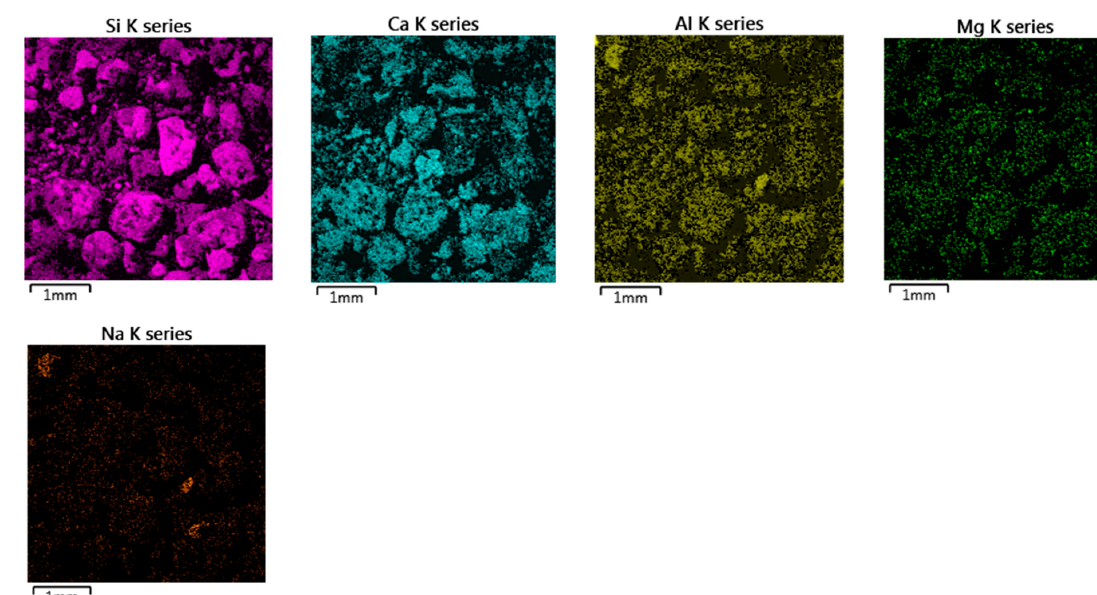
Materials 2021 , 14 , x FOR PEER REVIEW